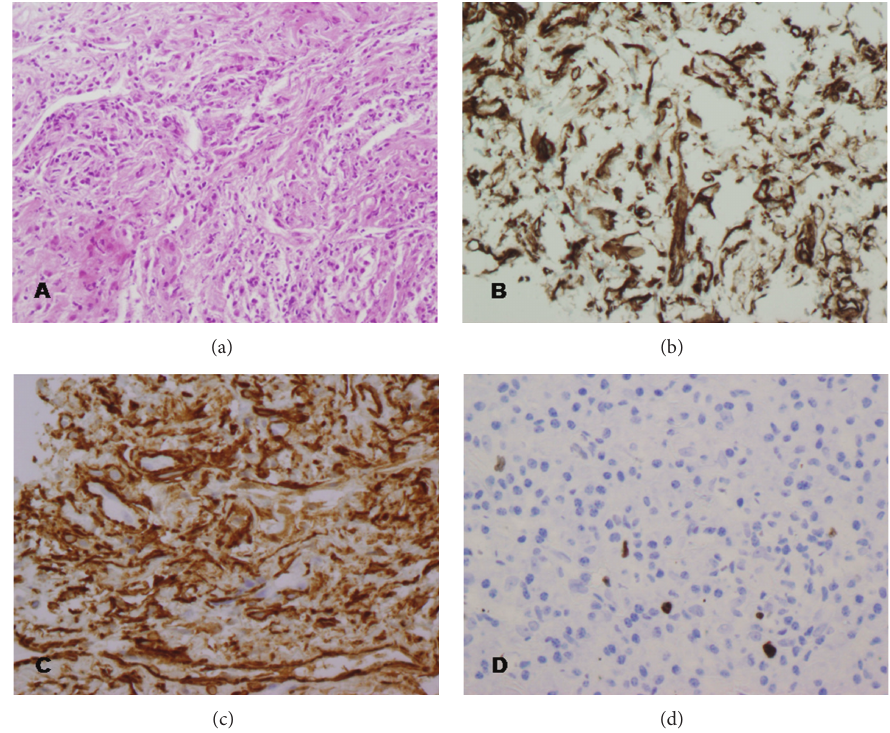
Figure 5: Histological and immunohistochemical examination of the pulmonary mass. (a) Hematoxylin-eosin staining demonstrating spindle cells sprinkled, with a predominance of plasma cells and lymphocytes (original magnification ×200 ). (b) immunohistochemical staining showing strong reactivity for vimentin (original magnification ×400 ). (c) Immunohistochemical staining showing strong reactivity for 𝛼 -smooth muscle actin (original magnification ×400 ). (d) Immunohistochemical staining showing weak immunoreactivity of the tumor cells for Ki-67 (original magnification ×400